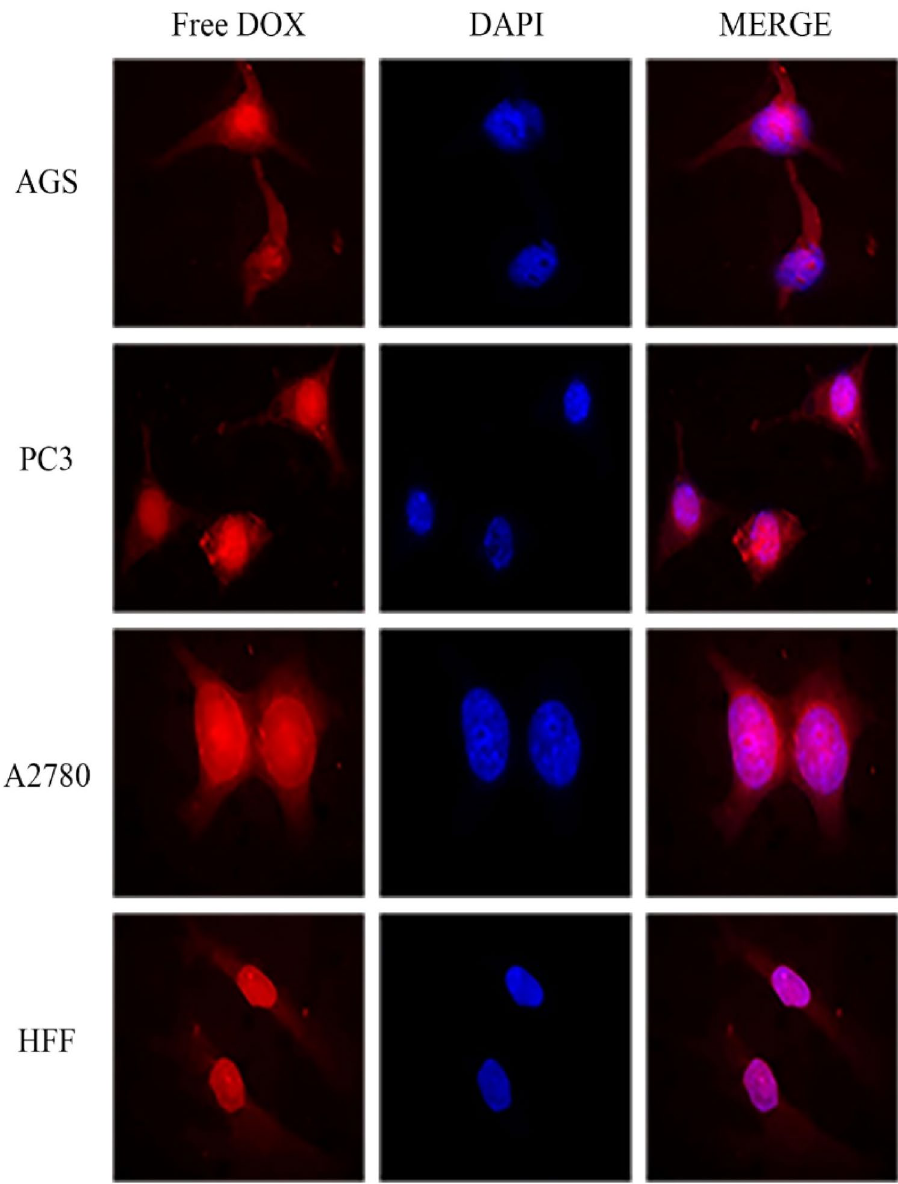
Figure 4. Cellular uptake images of AGS, PC3, A2780 and HFF cells incubated with free DOX for 180